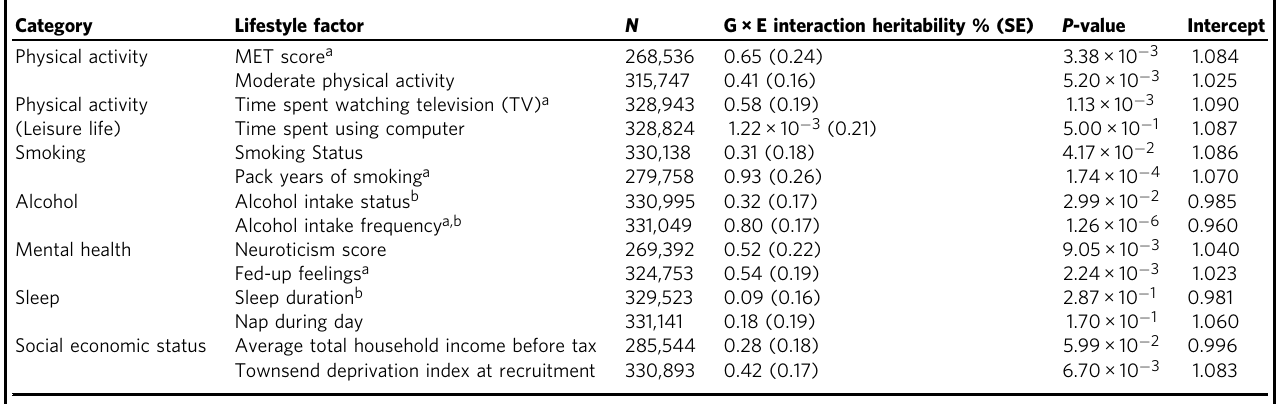
Table 2 G × E interaction heritability in BMI calculated using the LDSC method.